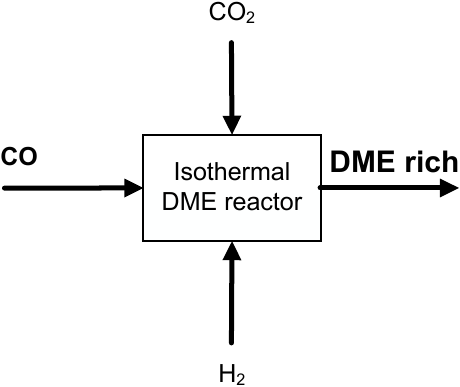
Figure 3. Thermodynamic analysis scheme.